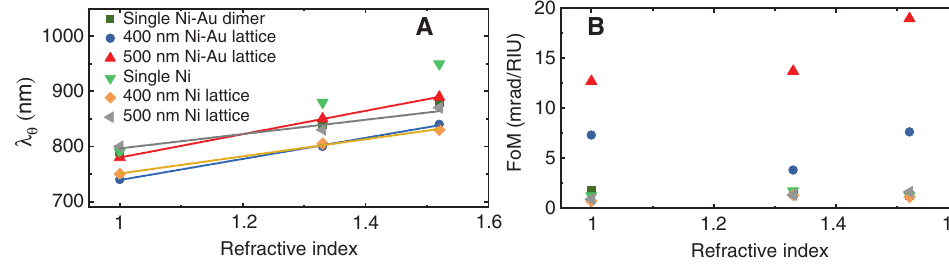
Figure 4: Summary of sensing performance of all magnetoplasmonic samples. (A) Wavelength of zero Faraday rotation ( λ ) and (B) FoM as a function of the refractive index of the embedding θ